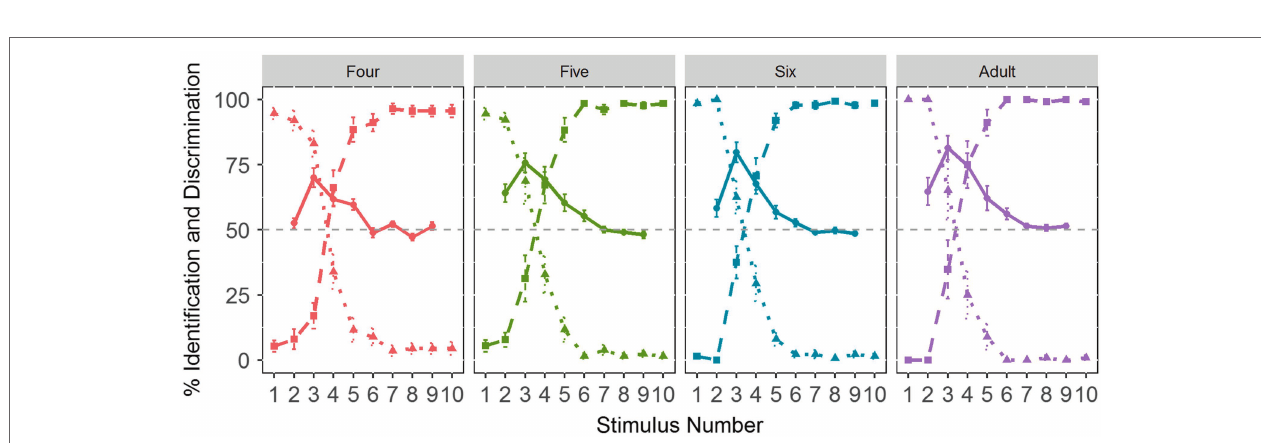
FIGURE 7 | Means and standard errors of the between- and within-category discrimination scores for the Tone 1-2 continuum across age groups. Error bars: ±1 standard error.